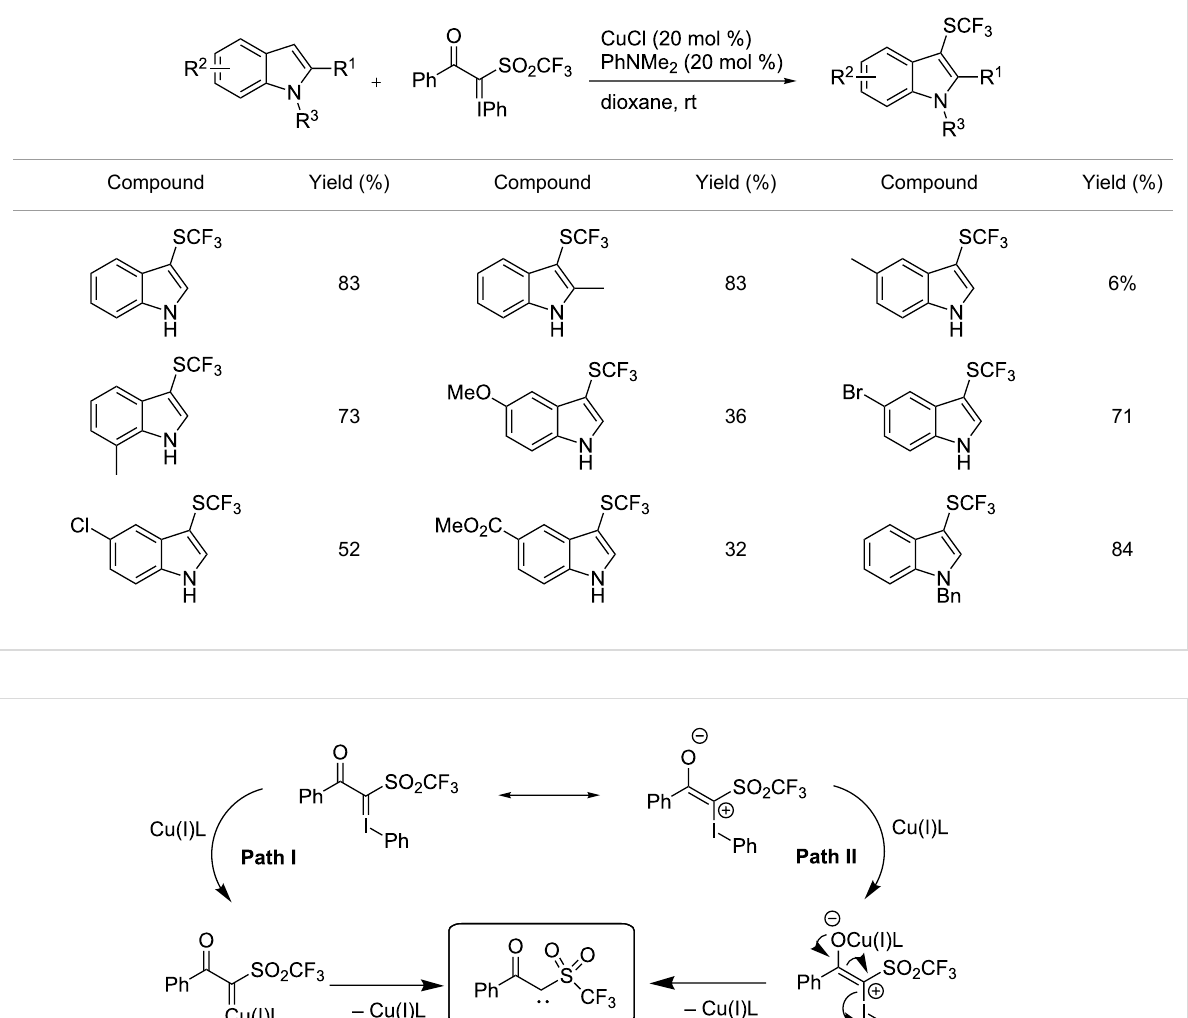
Table 47: Cu-catalyzed trifluoromethylthiolation of aromatic C–H bonds with a trifluoromethanesulfonyl hypervalent iodonium ylide [138].